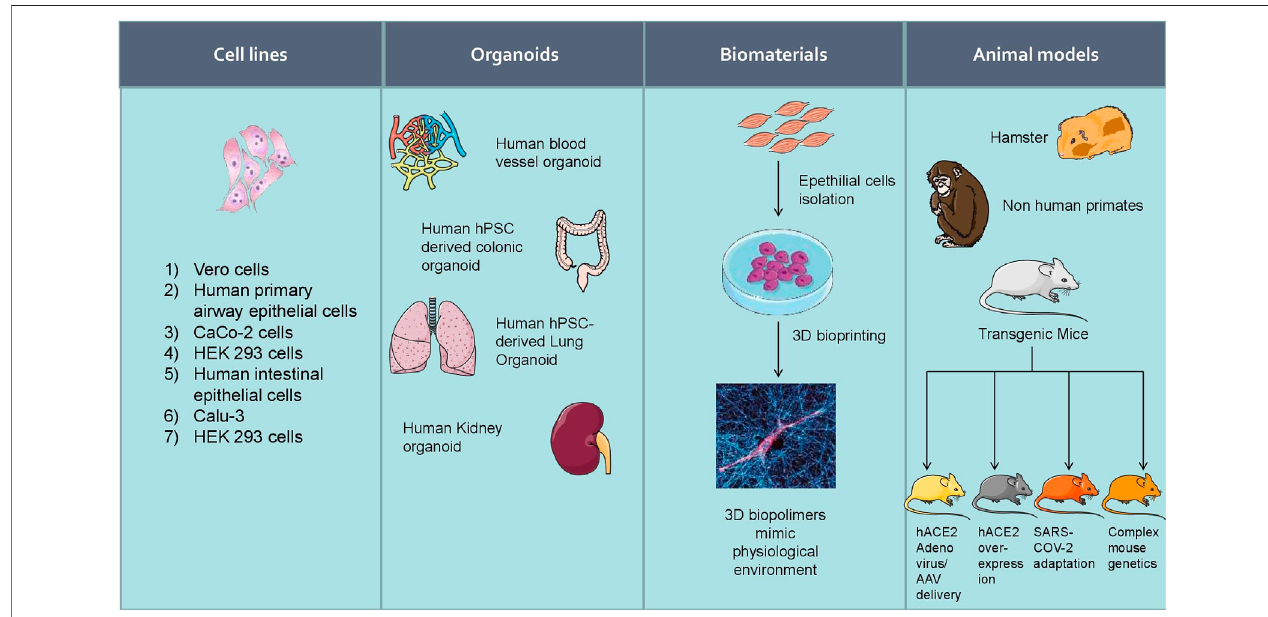
FIGURE 5 | Experimental models to study the pathogenesis of SARS-CoV-2 infection and study drug candidates ’ pharmacological action.